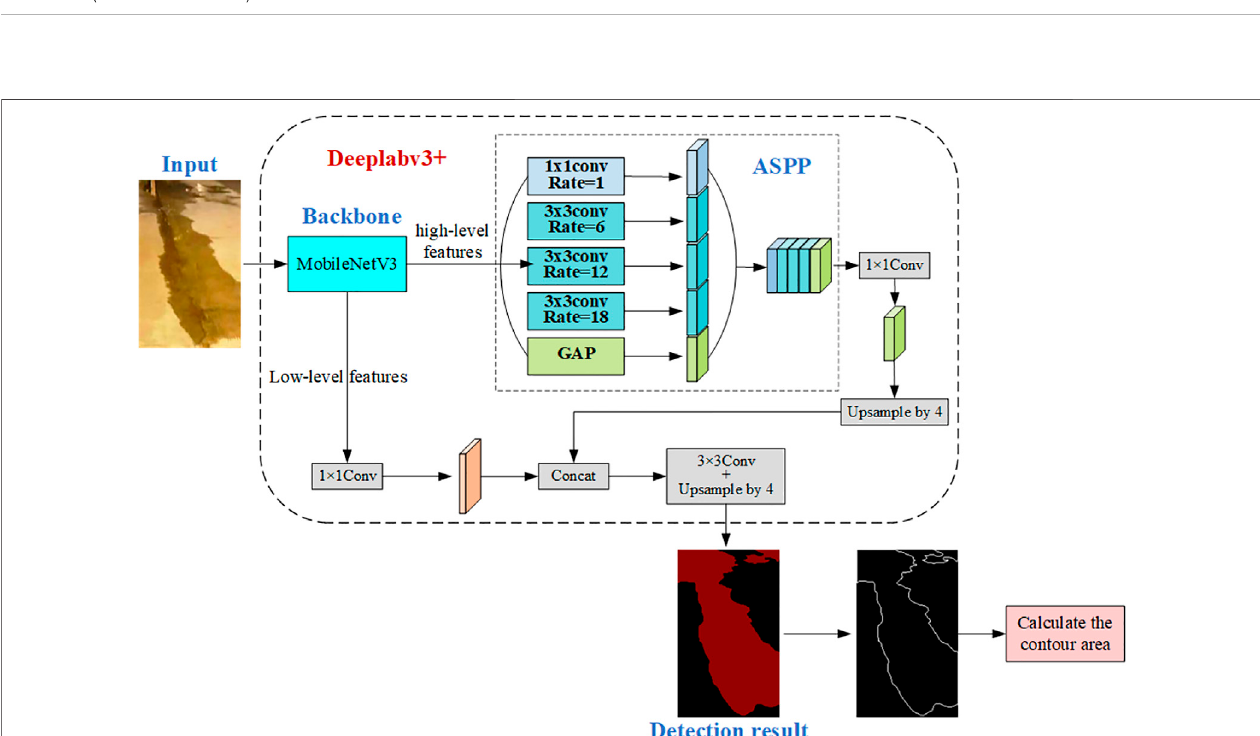
FIGURE 7 | Ponding area identi fi cation process.